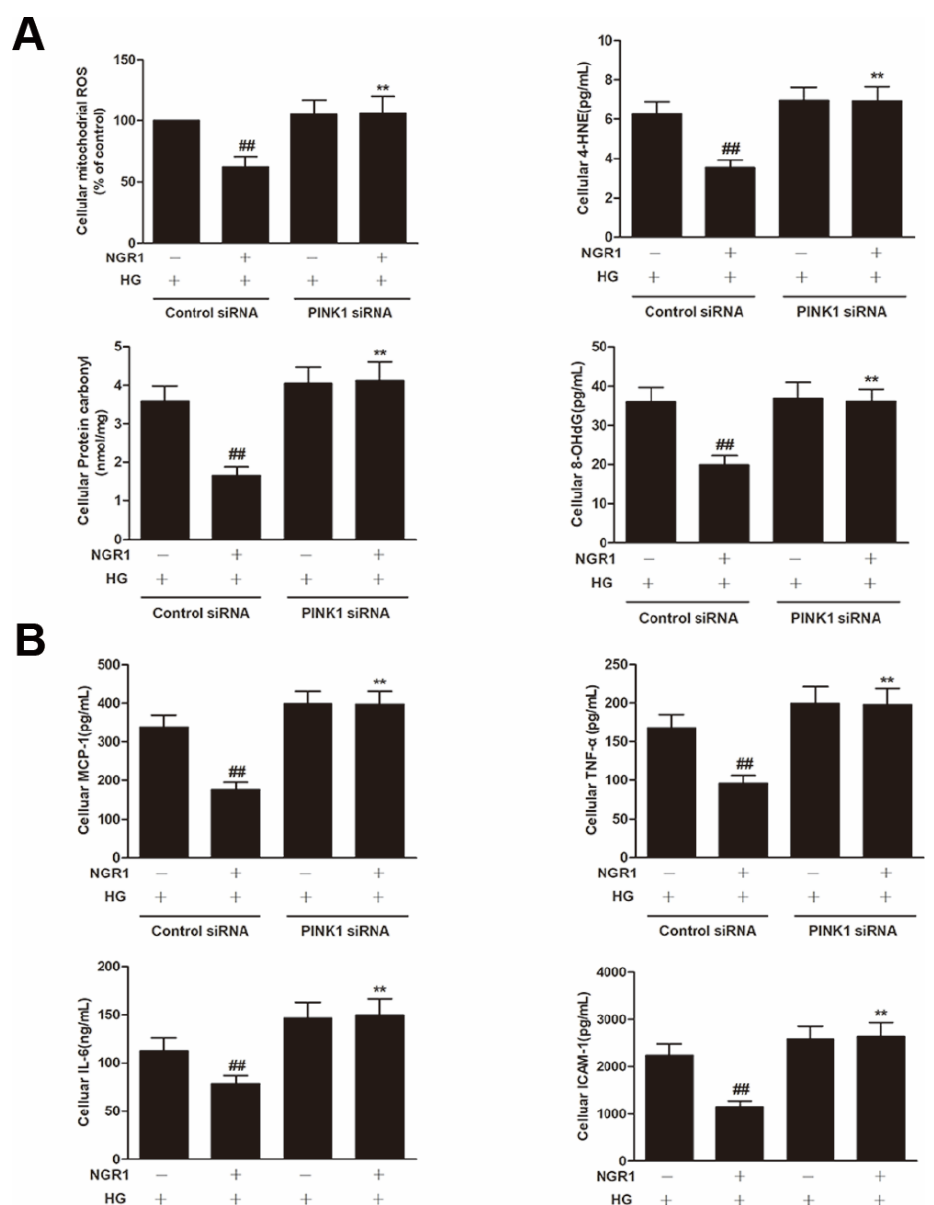
Figure 11. NGR1 suppressed oxidative stress inflammation by activating PINK1. rMC cells were transiently transfected with PINK1 siRNA. ( A ) The expression of cellular mitochondrial ROS, 4HNE, protein carbonyl and 8-OHdG. ( B ) The expression of the inflammatory factors MCP-1, TNF- α , IL-6 and ICAM-1. The results are expressed as the means ± SD (n = 10). Two groups were analysed by unpaired two-tailed Student’s t tests, and multiple groups were analysed by one-way analysis of variance (ANOVA); ## indicates a significant difference from HG-treated cells transfected with control siRNA ( p < 0.01). ** indicates a significant difference from cells in the NGR1+HG group. (+), treatment with HG or NGR1; ( − ), treatment without HG or NGR1.